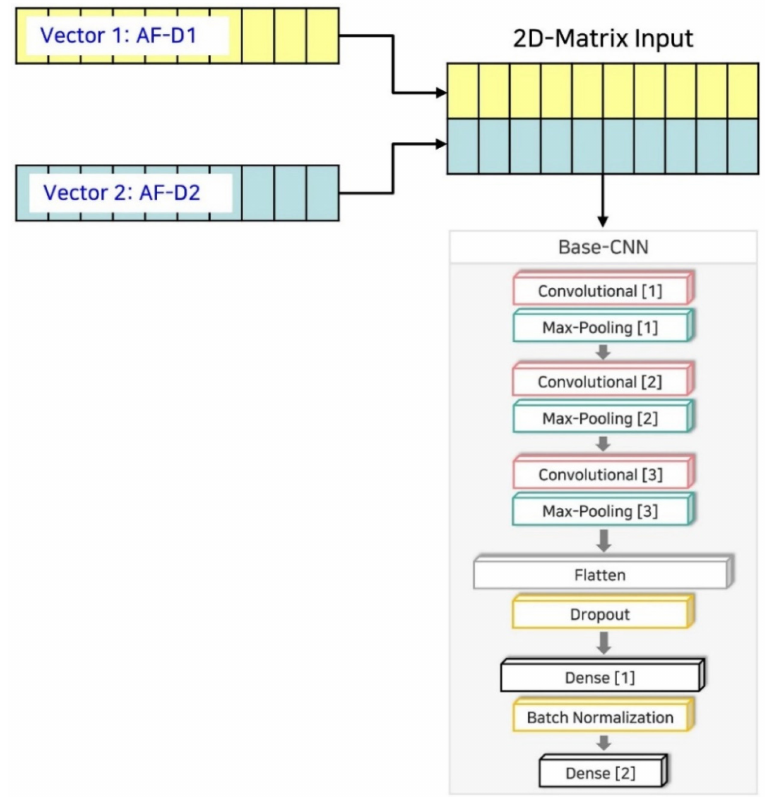
Figure 7. Dual-variate ECG analysis with Base-CNN using dataset AF-D1 and AF-D2 for the diagnosis of atrial